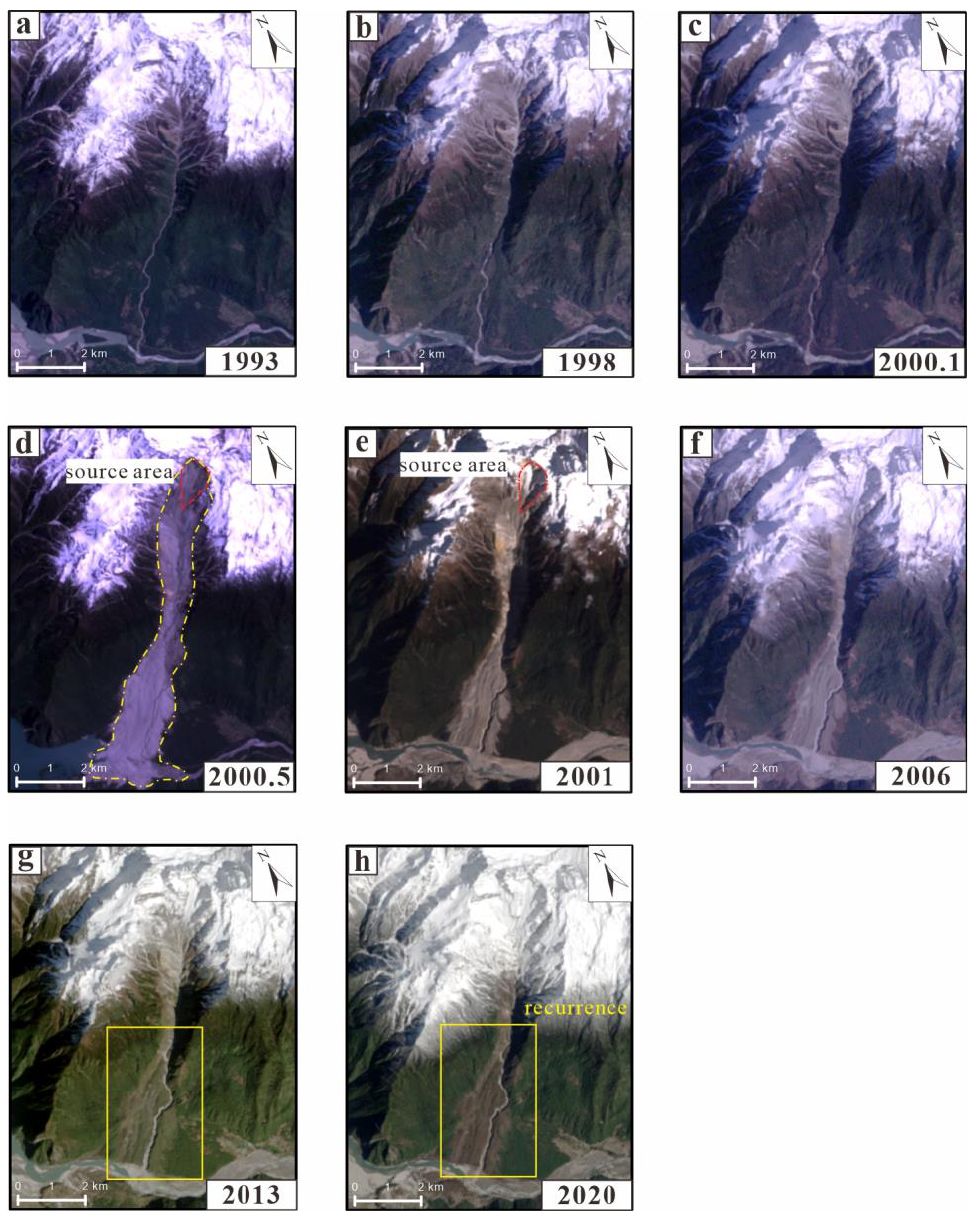
Figure 6. Historical remote sensing image of the Yigong landslide. ( a – h ) show the optical remote sensing images of Yigong landsldie from 1993 to 2020. Table 1. Remote Sensing Image Satellite Type Data.